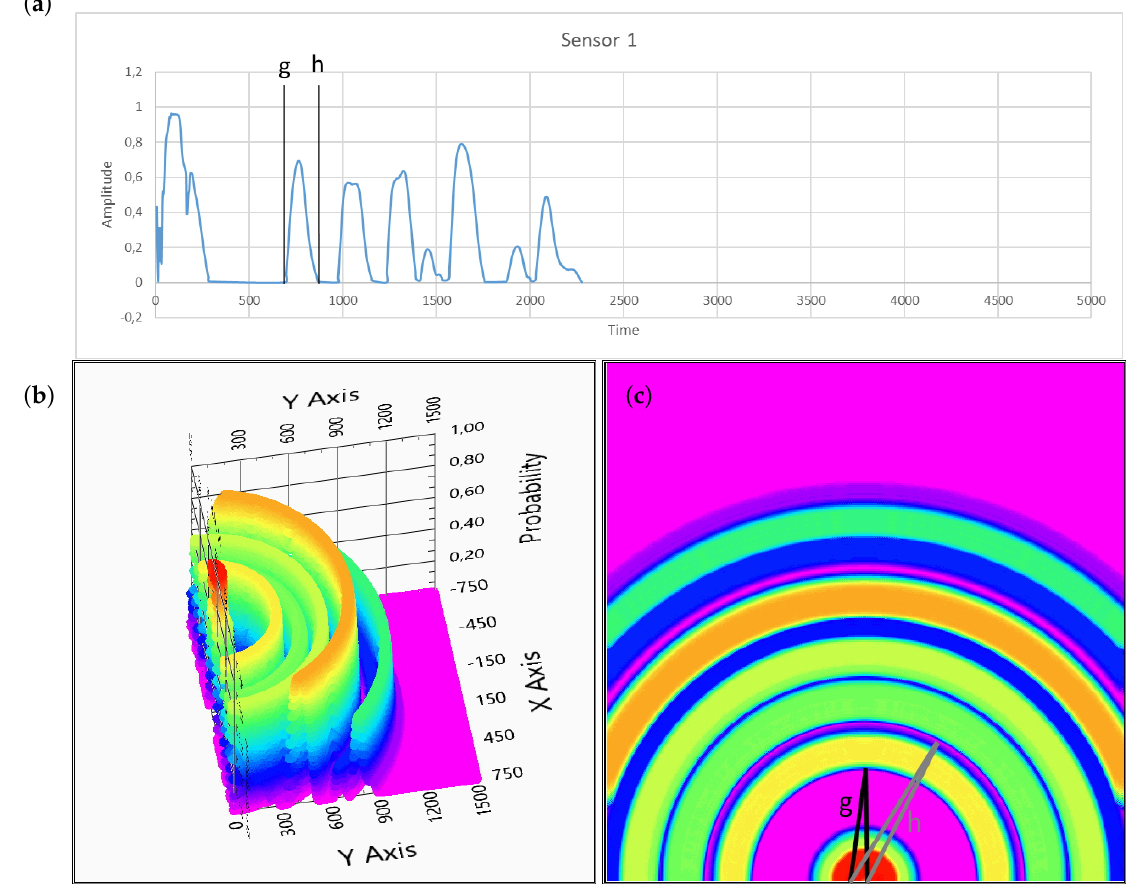
Figure 1. The signal of a single transmitter receiver pair with the threshold already applied. Subplot ( a ): the envelope of the received signal. Subplot ( b ): 3D visualization of the excluded—pink and possibly other colors—locations of the obstacles based on the above measured signal. Subplot ( c ): top view of Subplot ( b